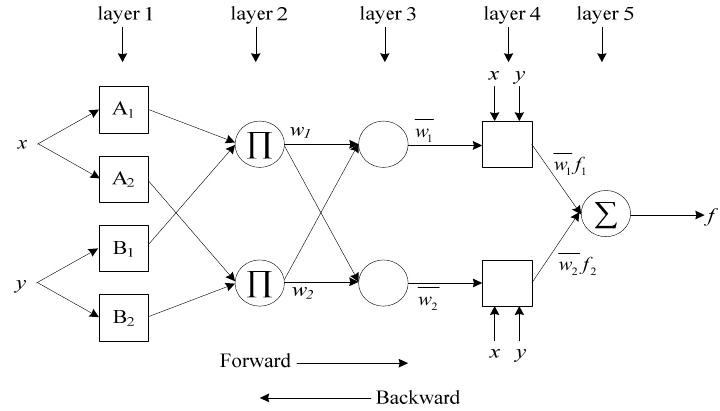
Fig. 1. An ANFIS architecture of two inputs and two